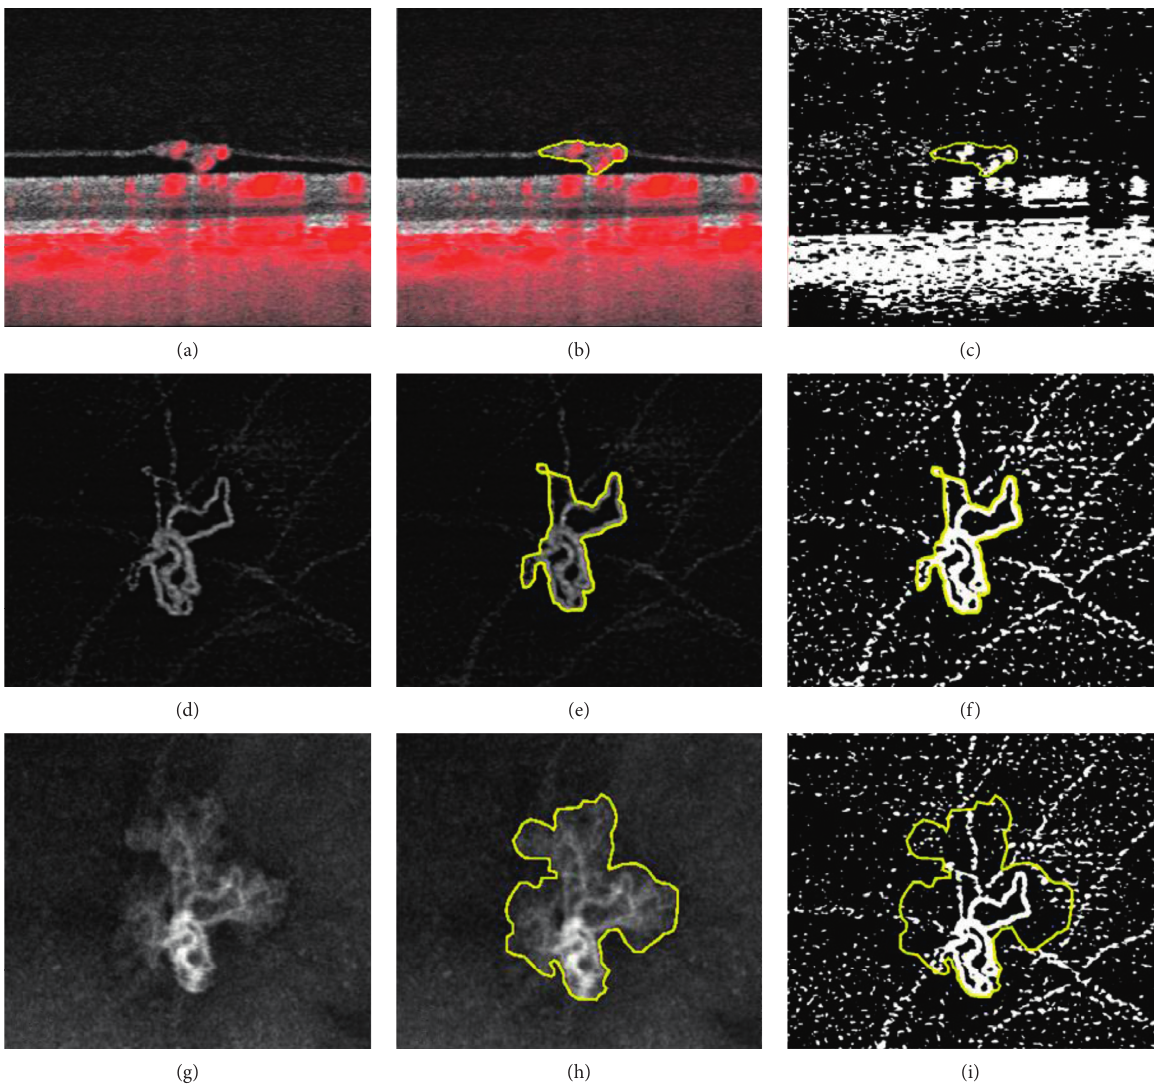
Figure 1: Summary of image processing steps. The first column shows the images generated by the optical coherence tomography an- giography; a B-scan structure image with flow overlay in red (a), an en face flow (angio) image (d), and an en face structural (structure) image (g). Borders of the neovascularization were manually delineated for each image (second column: (b, e, h)), and the areas were measured. After binarization of the flow information, flow density was measured in percentages of white pixels within the respective area (last column: (c, f,